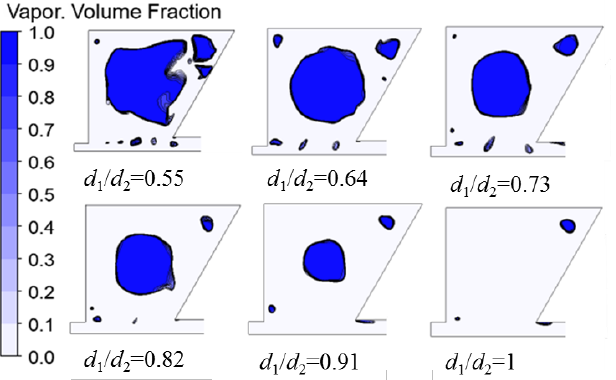
Figure 11. Steam pocket regions of the nozzle with different inlet diameters.